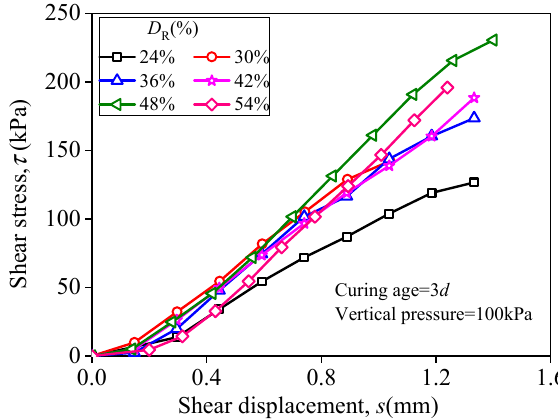
Figure 11. Relationship between shear stress and shear displacement.